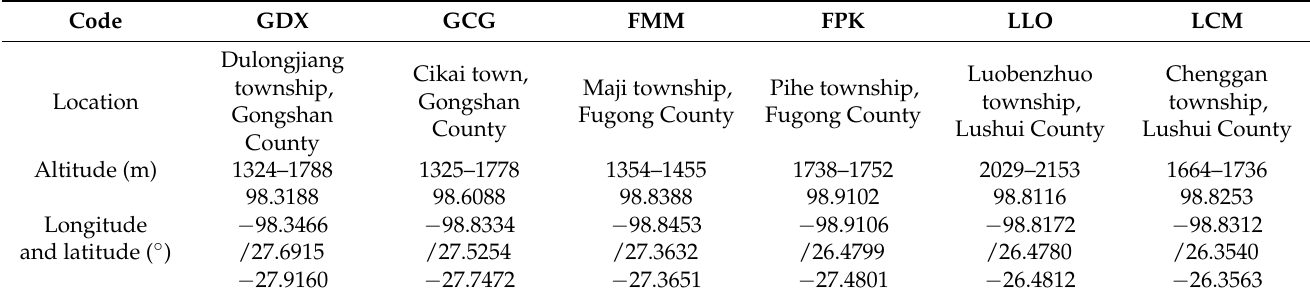
Table 6. The location and habitat of the 6 L. yunnanensis